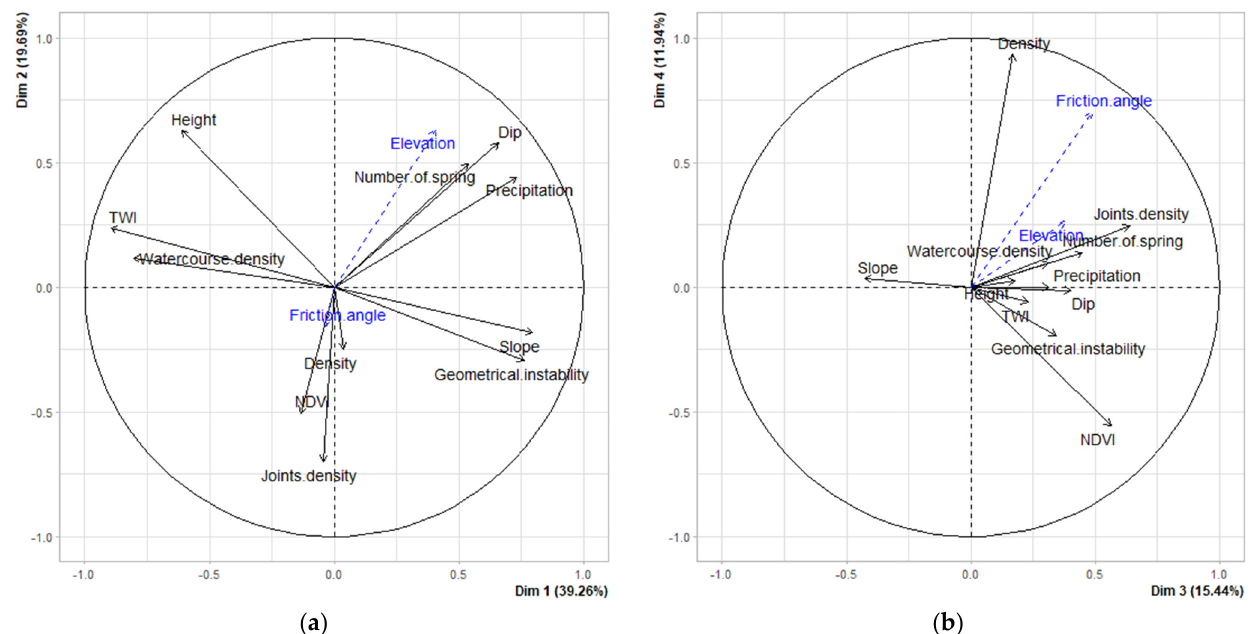
Figure 13. Correlation circle of variables. Rockfall PCA - along ( a ) axis 1 and 2; ( b ) axis 3 and 4.